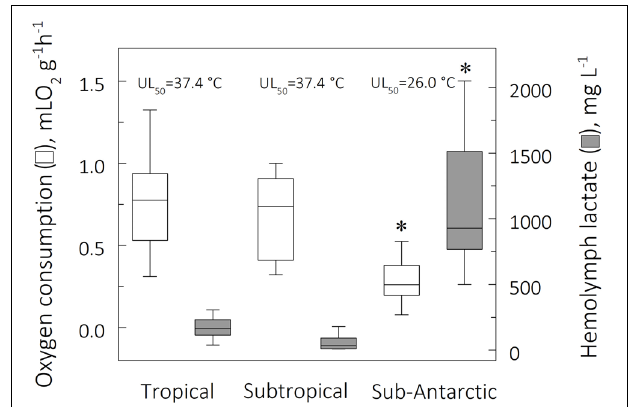
FIGURE 4 | Mean mass-specific oxygen consumption (QO 2 , mL O 2 g − 1 h − 1 ) and mean hemolymph lactate concentrations (mg L − 1 ) for tropical, subtropical and sub-Antarctic crab species at their respective UL 50 , after 6 h direct transfer from their corresponding field reference temperatures of 26, 15, and 9 ◦ C. The horizontal line within each box indicates the median QO 2 while the box boundaries show the interquartile values. Whiskers indicate the lowest and highest QO 2 ’s (range). Specimens (12 ≤ N ≤ 41 per species) for all species sampled from each zoogeographical province were used to provide the plots. *Significantly different from tropical and subtropical species (phyHolm-Bonferroni, P ≤